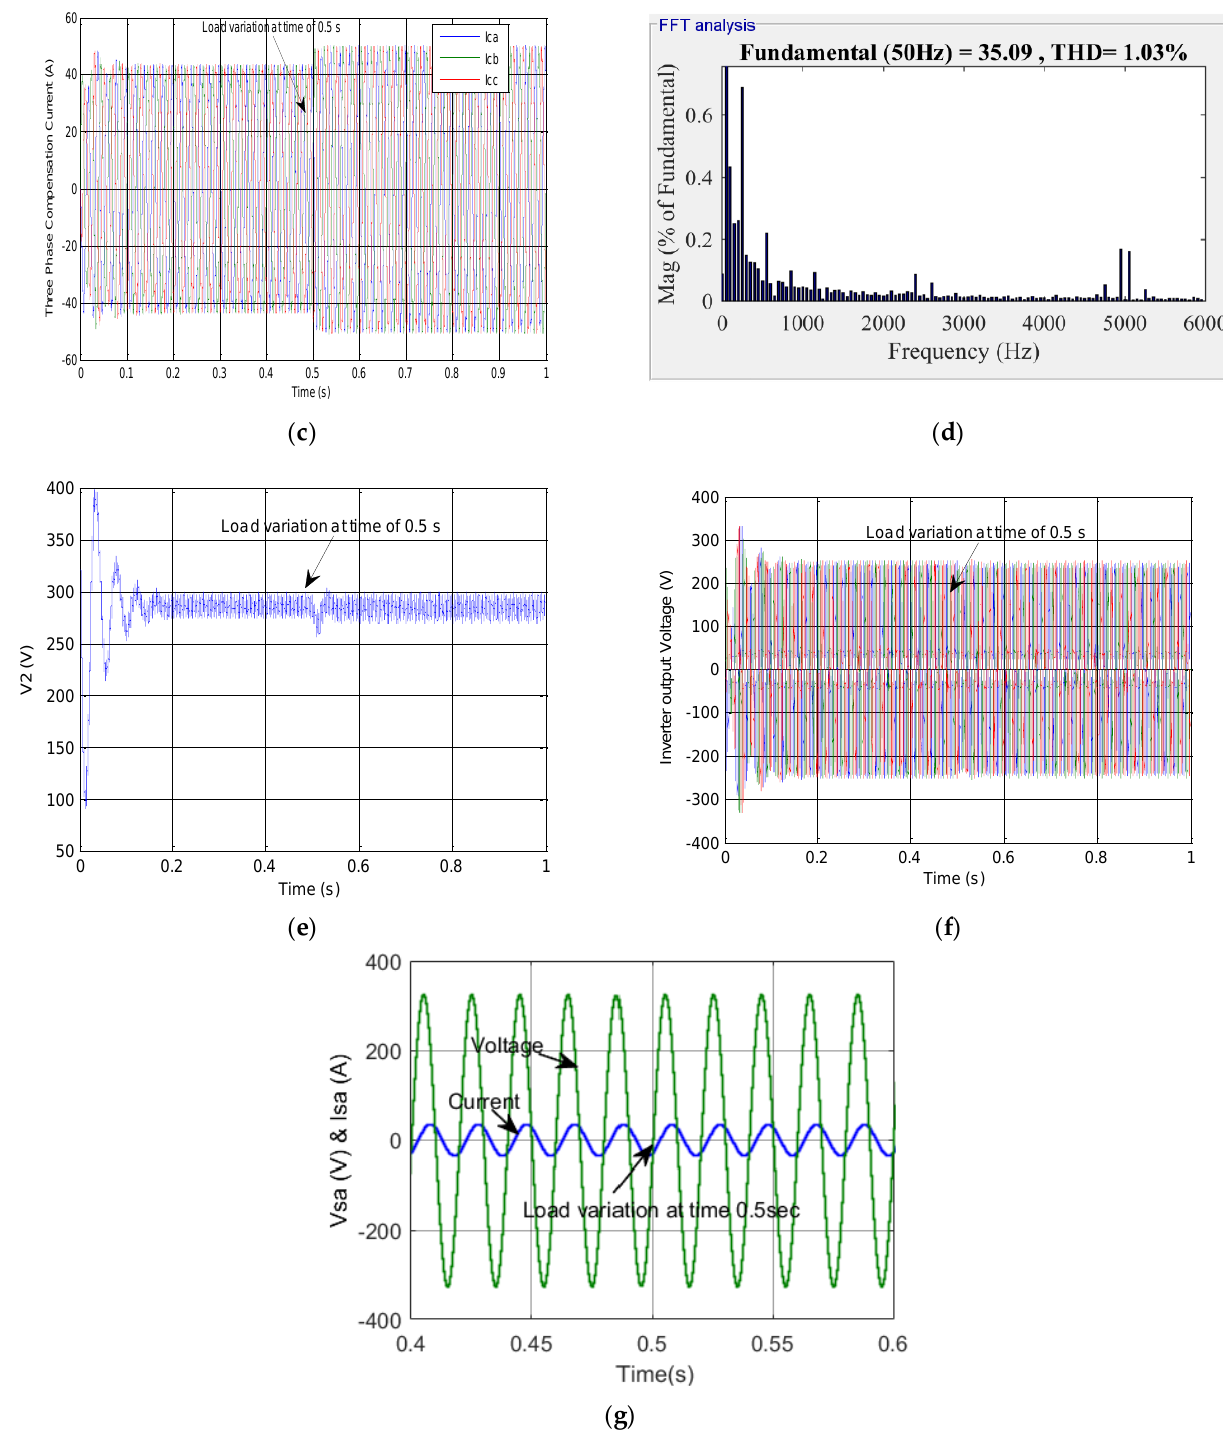
Figure 12. Simulated responses of three phase SSI-based SAPF connected at DRB RL load with SPWM and PI controller: ( a ) Supply current, ( b ) load current, ( c ) compensation current, ( d ) THD, ( e ) V 2 DC links voltage, ( f ) SSI output voltage and ( g ) source voltage (V sa ) and source current (I sa ) of phase A.